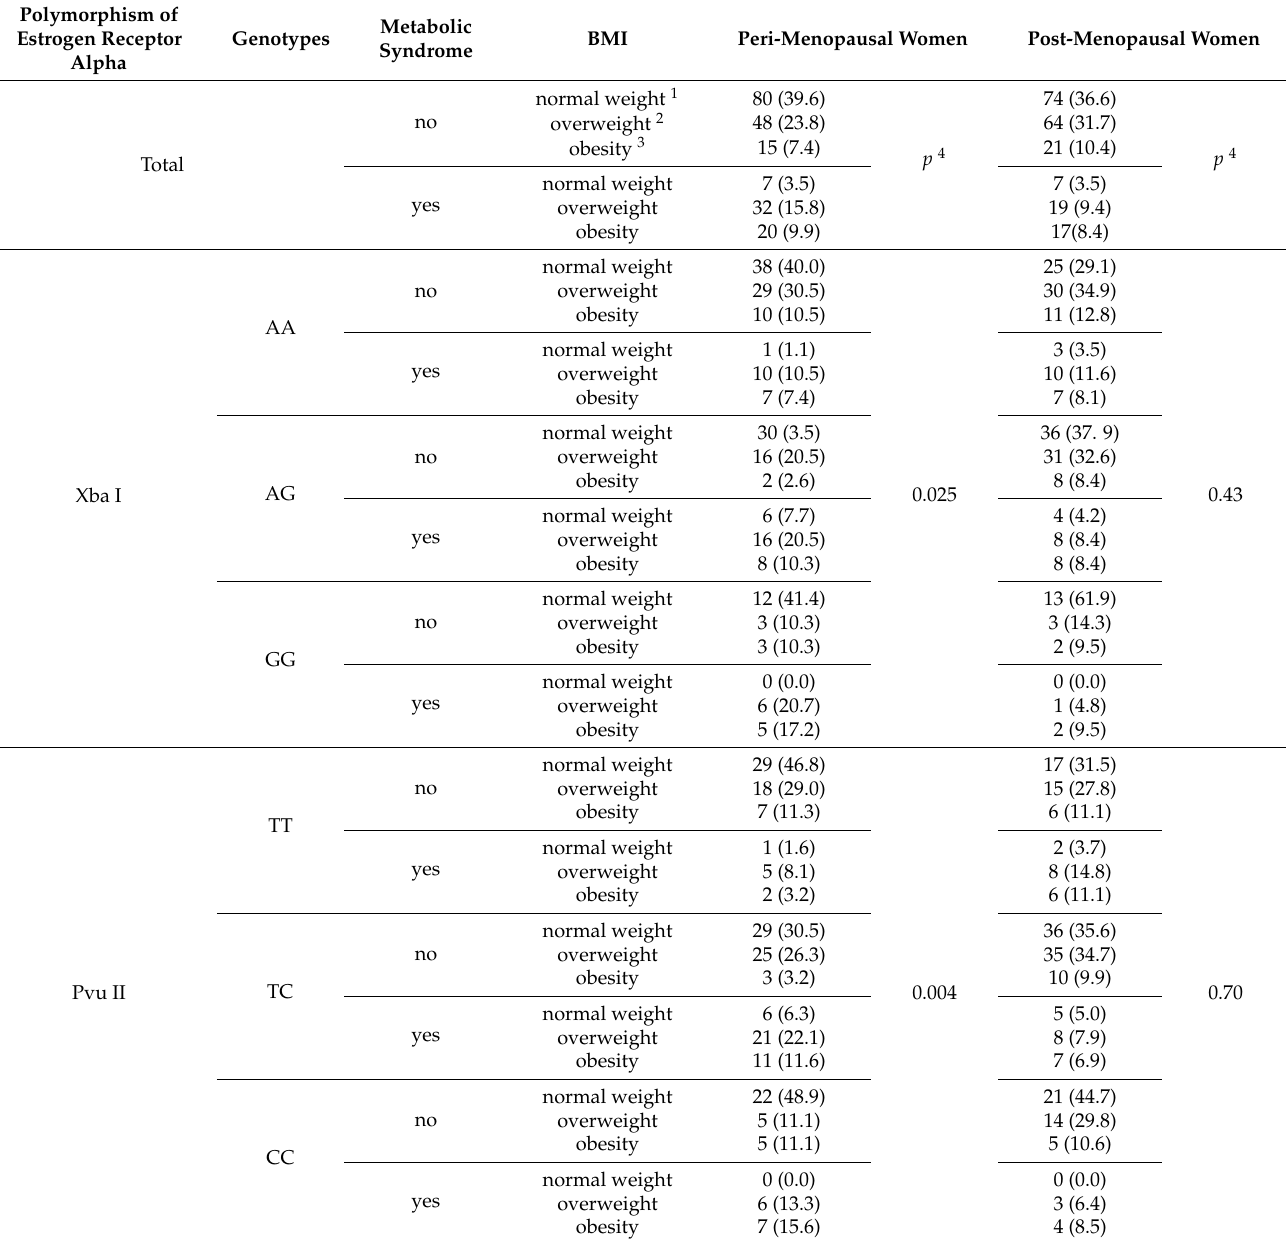
Table 6. Metabolic syndrome and BMI in peri- and post-menopausal women in total and by polymor- phism of estrogen receptor alpha: Xba I and Pvu II.